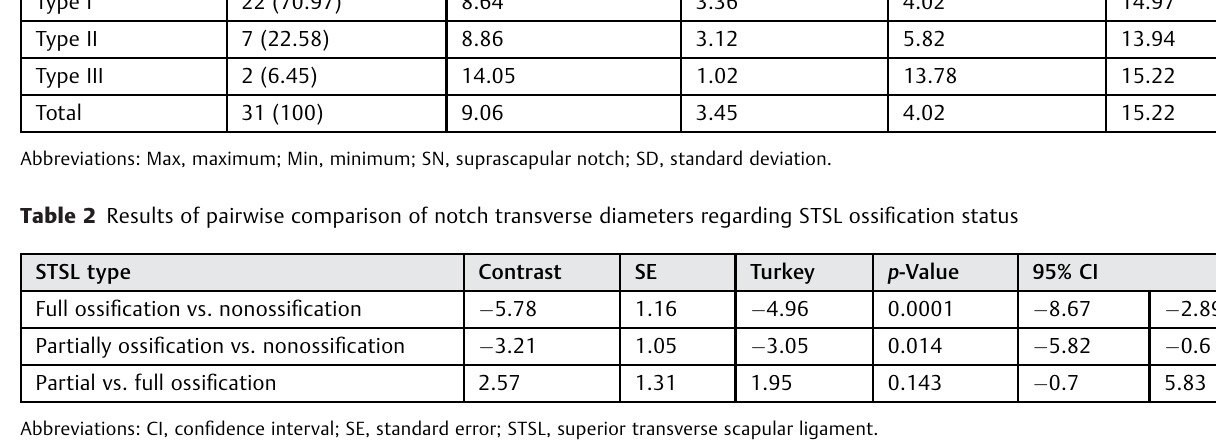
Table 1 Middle-transverse diameters categorized by SN ’ s content type (classi fi cation by Polguj et al) Scapulae